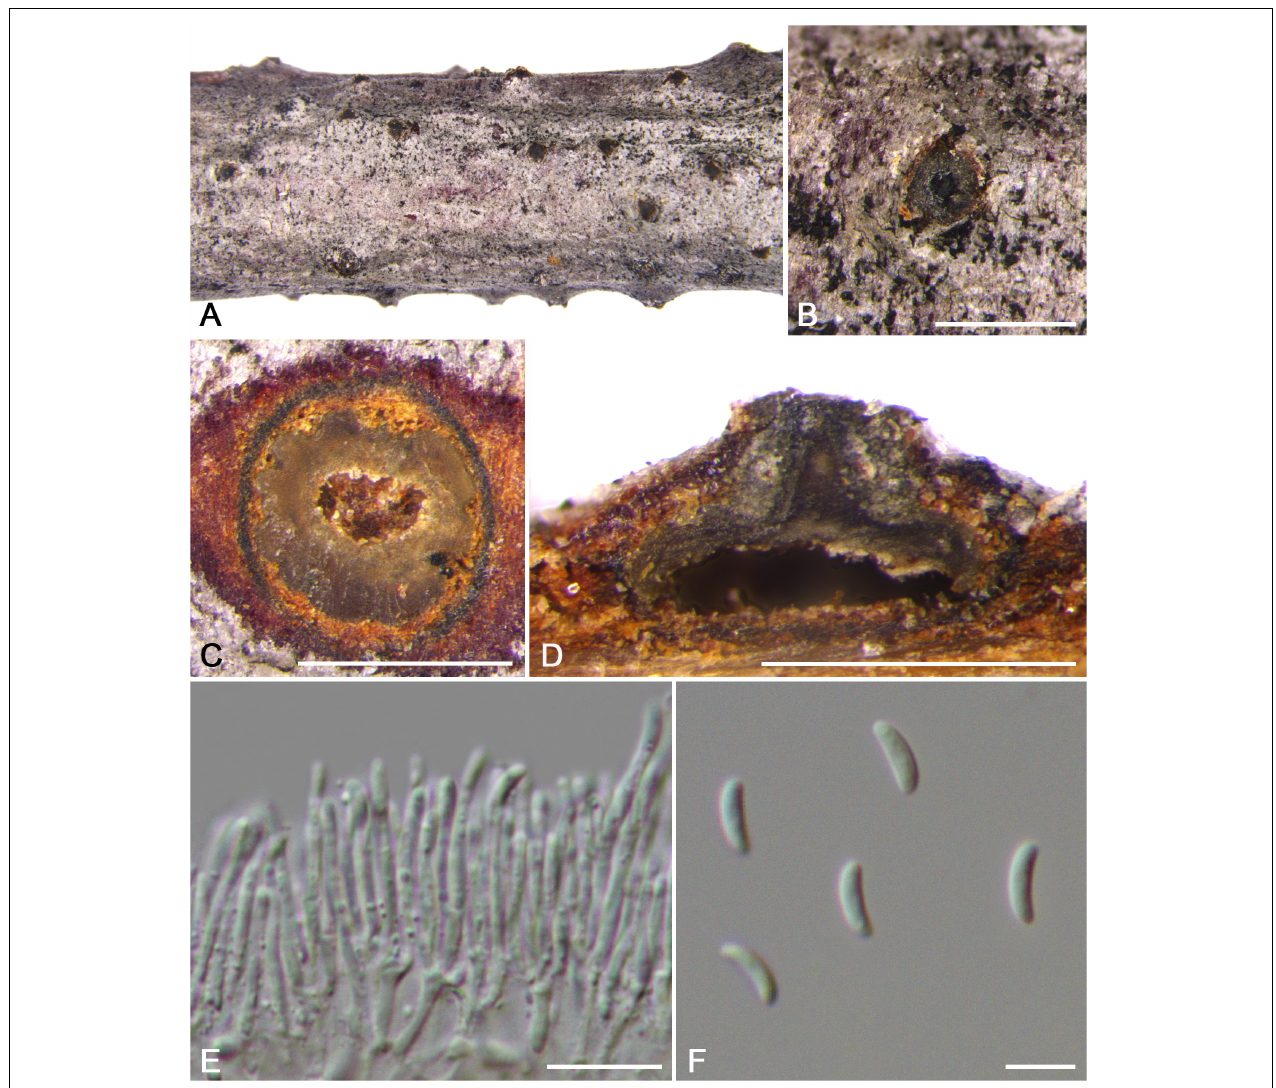
FIGURE 13 | Morphology of Cytospora tibetensis from Cotoneaster sp. (CF 20197032). (A,B) Habit of conidiomata on twig. (C) Transverse section of conidioma. (D) Longitudinal section through conidioma. (E) Conidiophores and conidiogenous cells. (F) Conidia. Bars: (B–D) = 500 µ m; (E) = 10 µ m; (F) = 5 µ